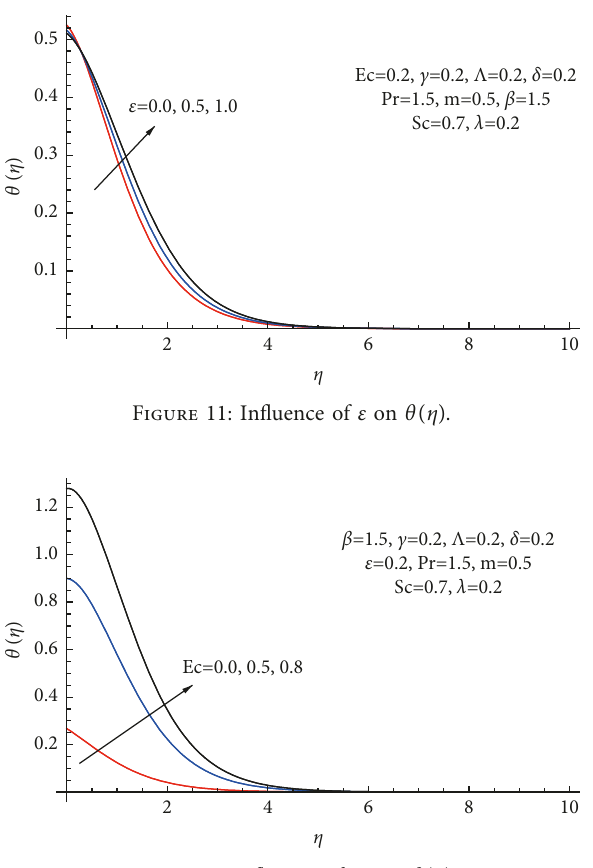
Figure 14: Influence of c on θ ( η ) .